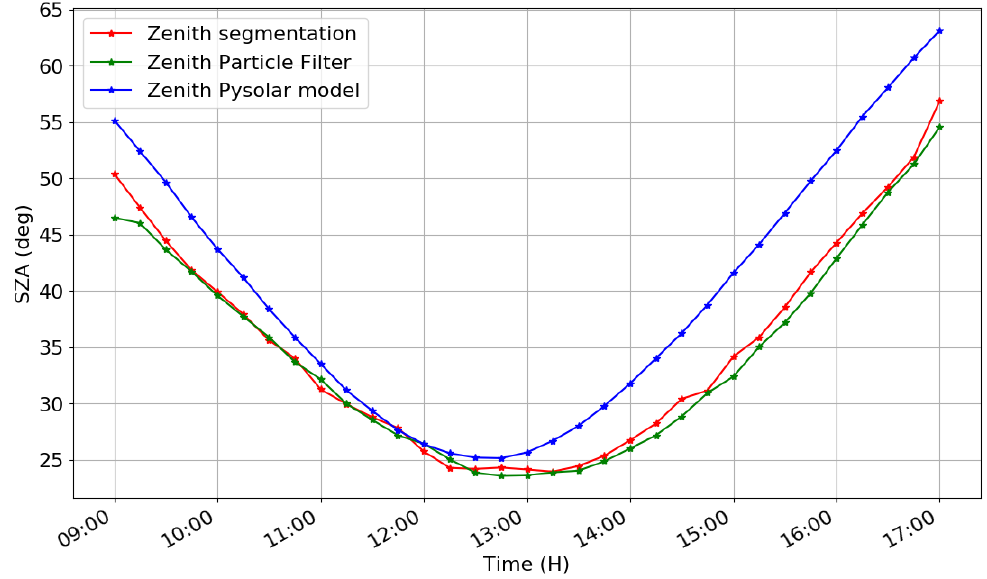
Figure 25. Solar zenith angle